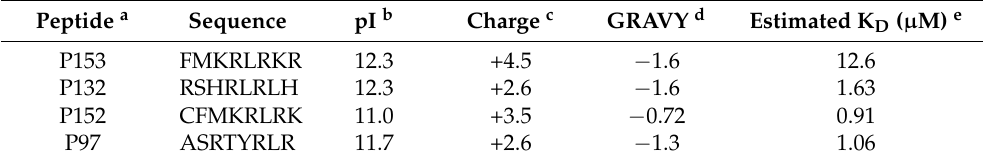
Figure 2. Blank subtracted fluorescence intensity profile of each peptide after binding assay with Alexa Fluor ® 488 − labeled CD81 protein. Error bars show SD (n = 3). The red line indicates AVG + 2SD. Peptide numbers 76 to 153 were EWI-2 − derived peptides. Peptide numbers 154 to 157 were control peptides, AAAA, DDDD, RRRR and KKKK, respectively. Table 1. A list and characteristics of CD81-BP candidates from EWI-2. Peptide a